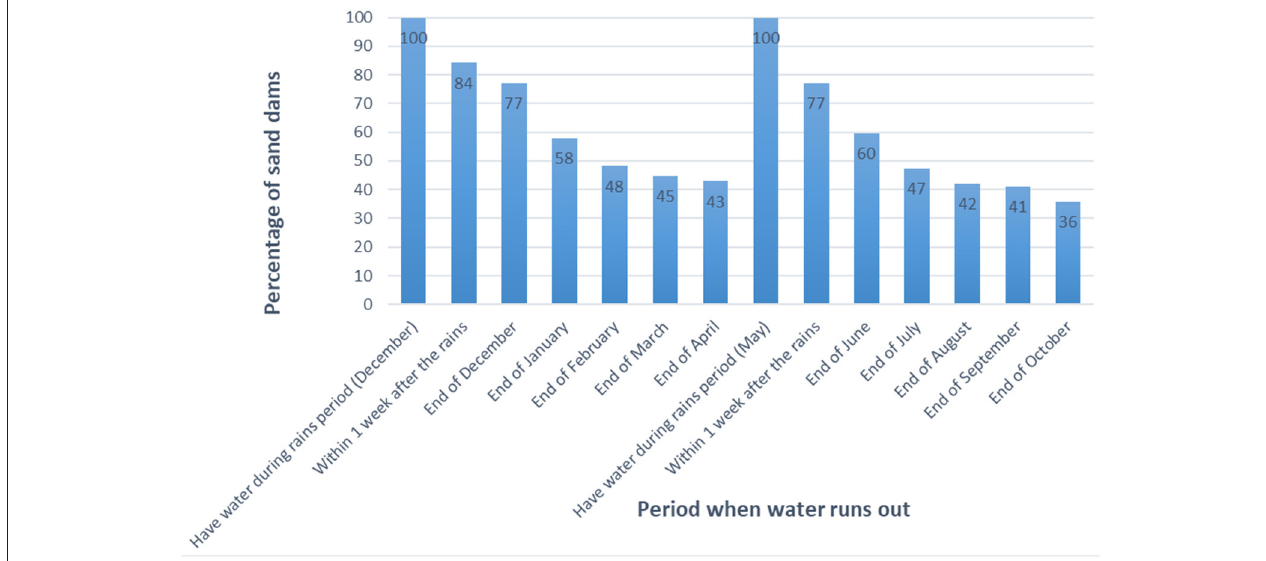
FIGURE 5 | Water storage of sand dams in the year (Ngugi et al., 2020).